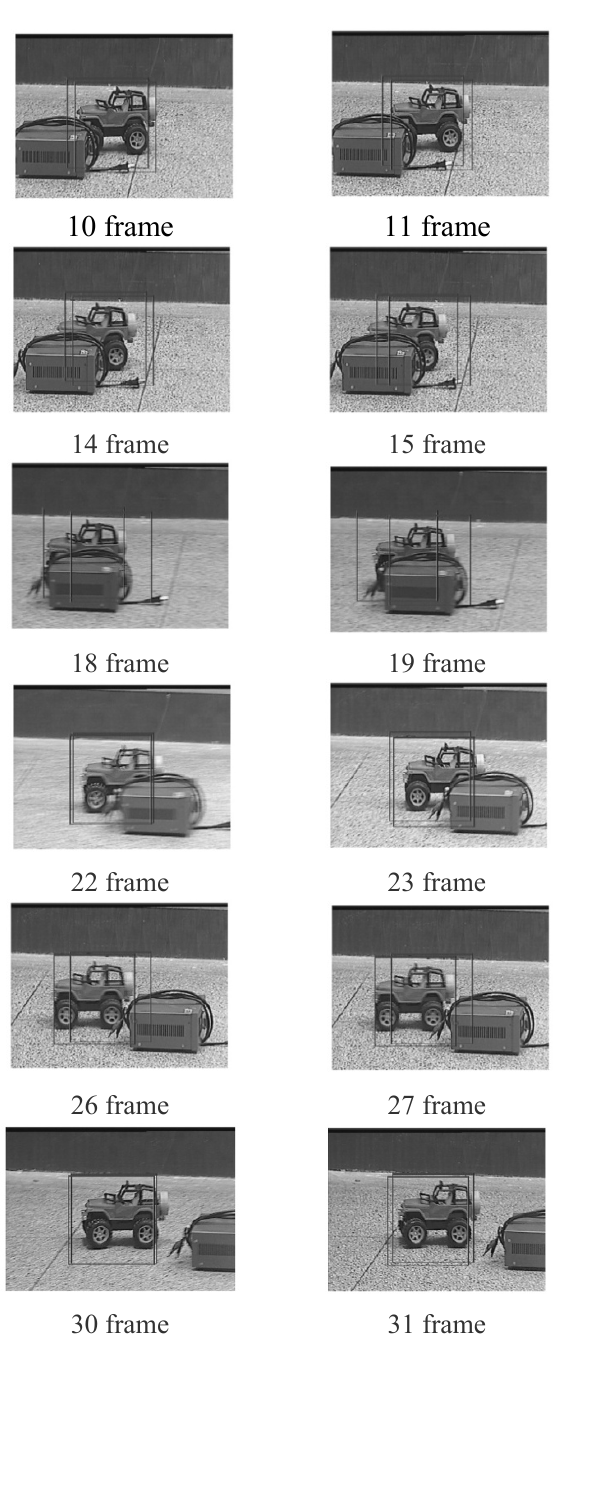
Figure 12. Tracking with proposed method in case of